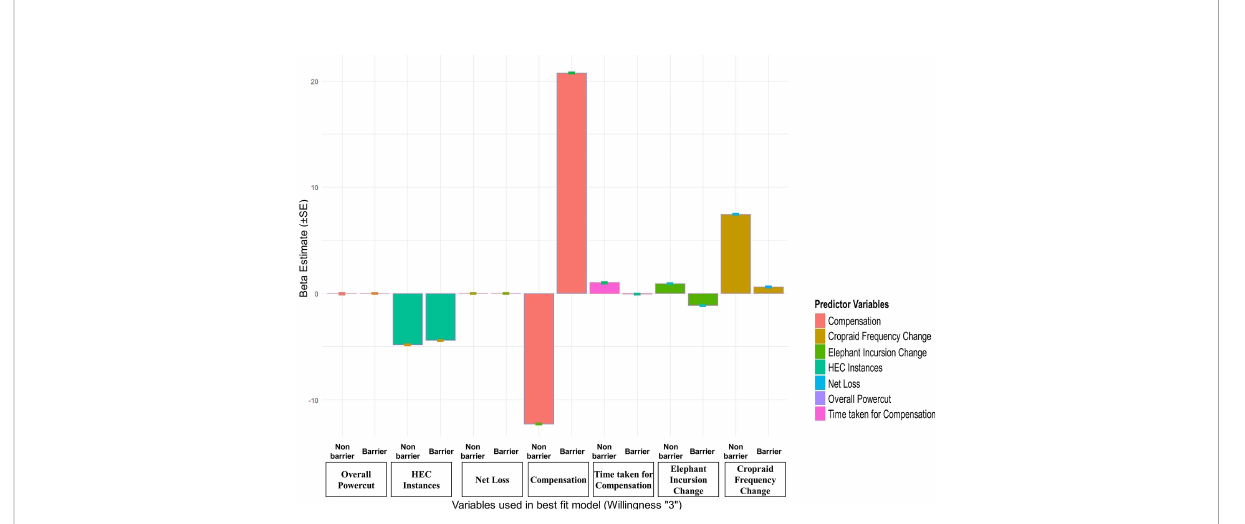
FIGURE 9 Comparisons of the relationship between beta estimates and different variables from least AICc model for category “ 3 ” (willing to pay for maintenance of barriers) for both barrier and non-barrier sites.